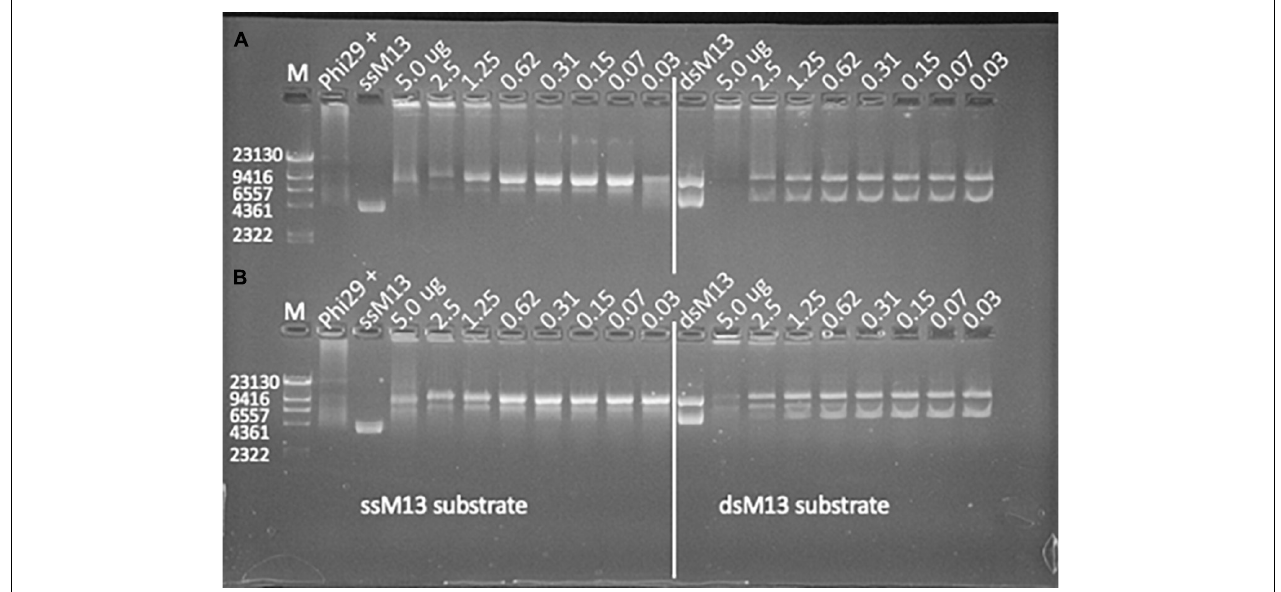
FIGURE 4 | In vitro primer extension and strand displacement in two synthesized virome polymerases. (A) F_S24 and (B) F_S21A at decreasing (left to right) concentrations ( µ g/reaction) in 1X phi29 buffer after 18.5 h incubation at 30 ◦ C. Both polymerases demonstrated primer extension and strand displacement from both single-stranded M13 (left) and double-stranded M13 (right) DNA templates. Strand displacement is evident in the phi29 DNA polymerase positive control after 10 min incubation at 37 ◦